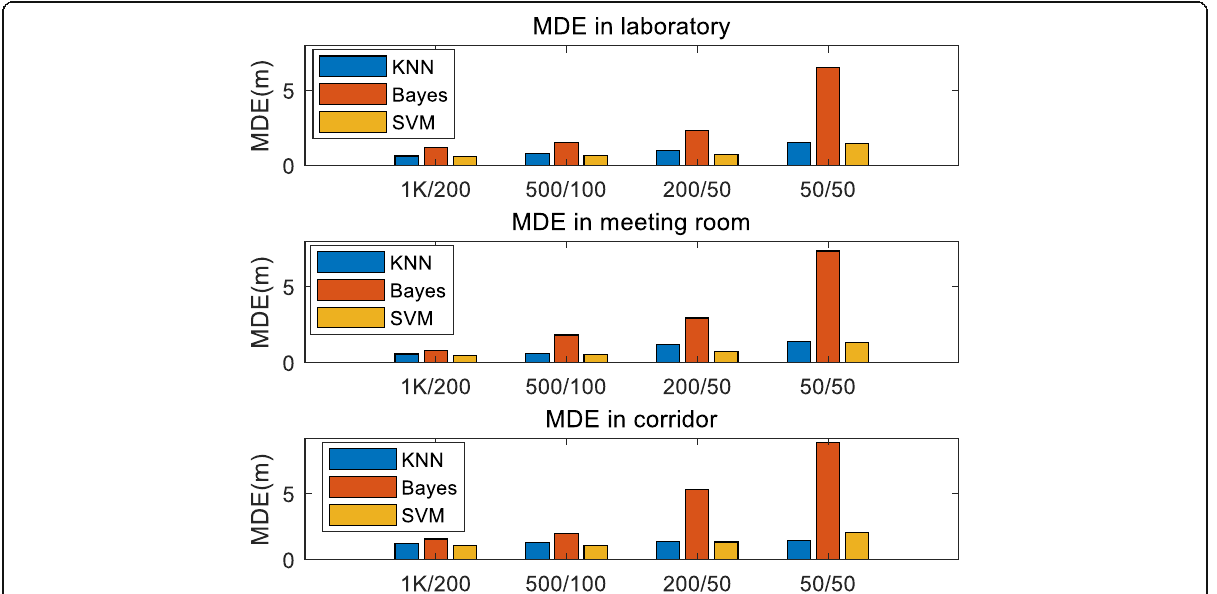
Fig. 9 MDE for different size of training and estimation samples. In the top figure, blue, orange, and yellow bar represent the median distance error of different size of training and estimation samples by using KNN, Bayes, and SVM as the match algorithm in the laboratory, respectively. In the middle figure, blue, orange, and yellow bar represent the median distance error of different size of training and estimation samples by using KNN, Bayes, and SVM as the match algorithm in the meeting room, respectively. In the bottom figure, blue, orange, and yellow bar represent the median distance error of different size of training and estimation samples by using KNN, Bayes, and SVM as the match algorithm in the corridor, respectively